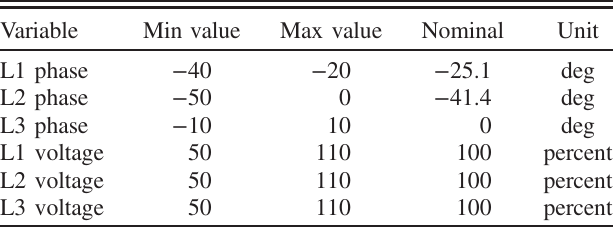
TABLE V. Details of wide scans over features for the LCLS beamline dataset.